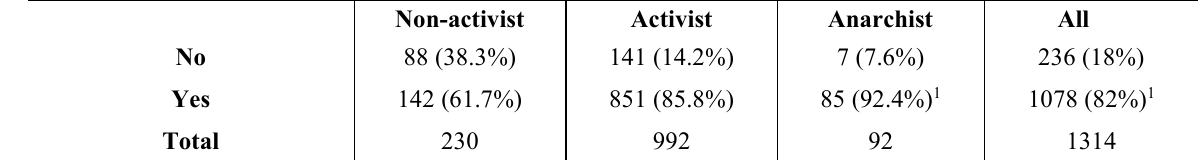
Table 9: Global Social